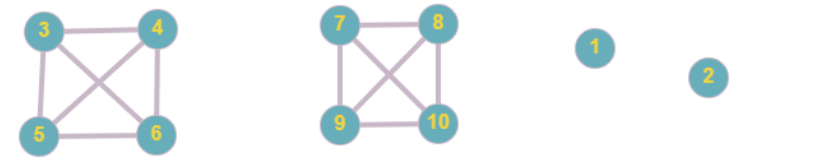
Figure 5. Decomposition